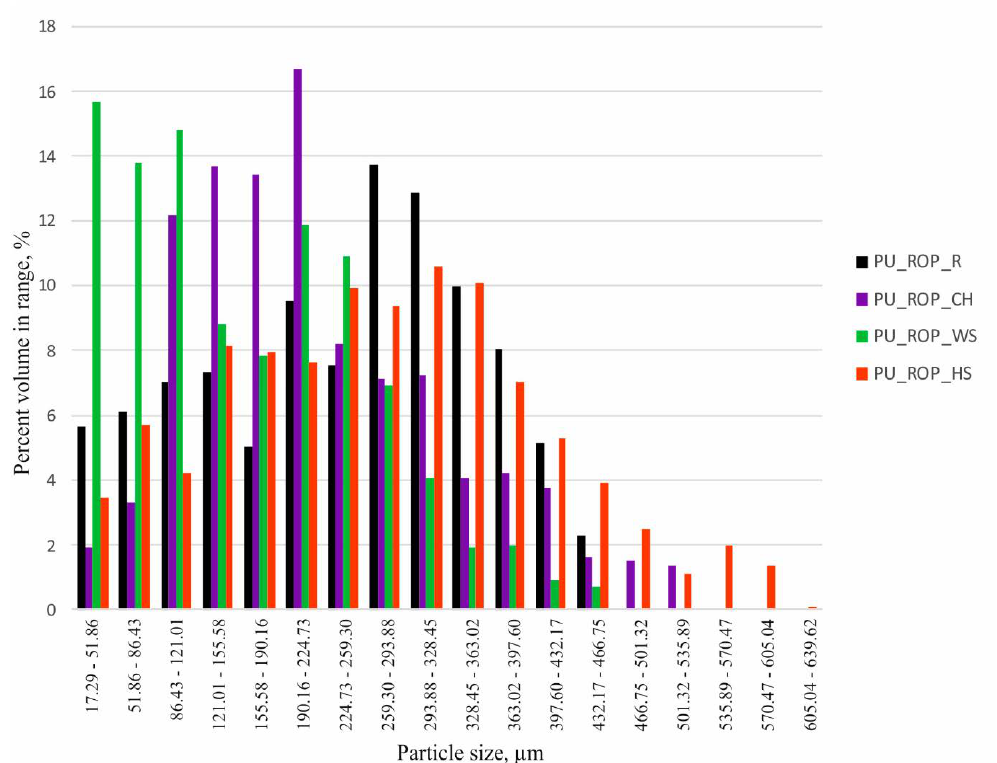
Figure 9. The filler size distribution for the PU_ROP_CH/R/WS/HS